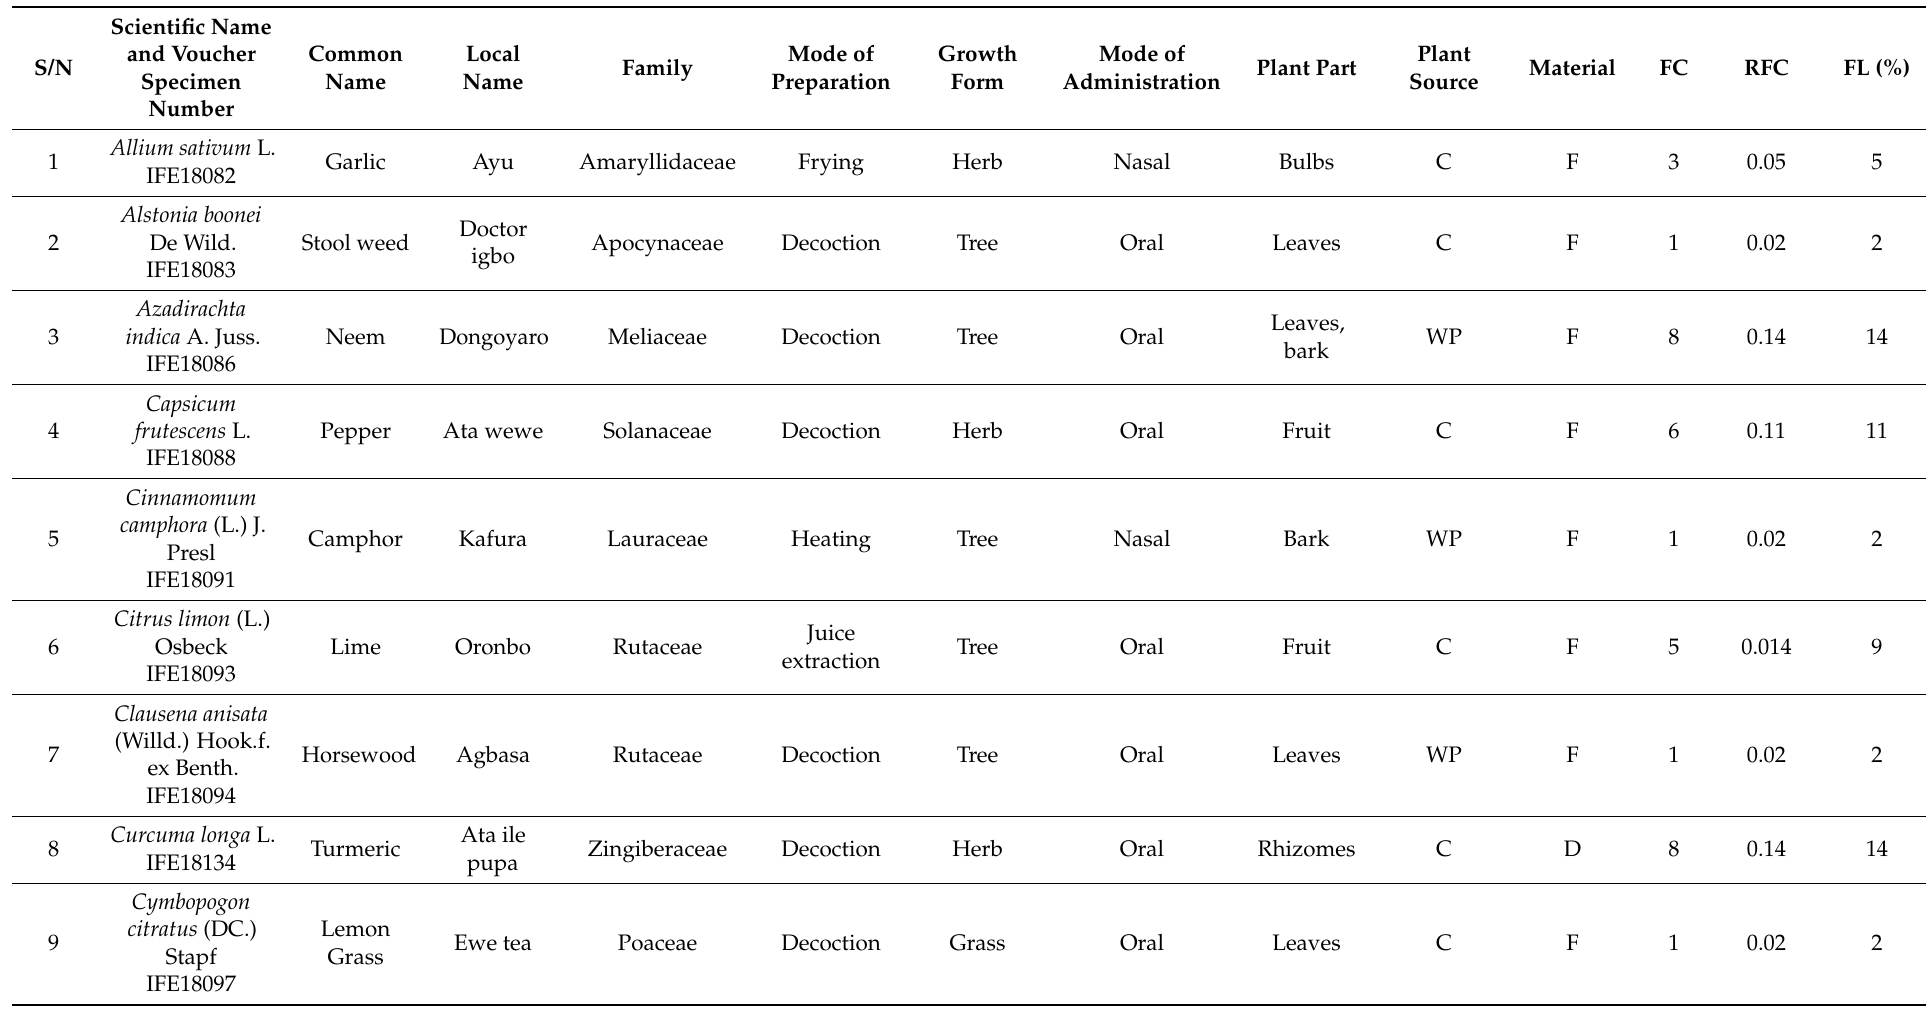
Table 2. Medicinal plants used to treat and prevent COVID-19 in Ogbomosho North and South Local Government Areas, Oyo State,